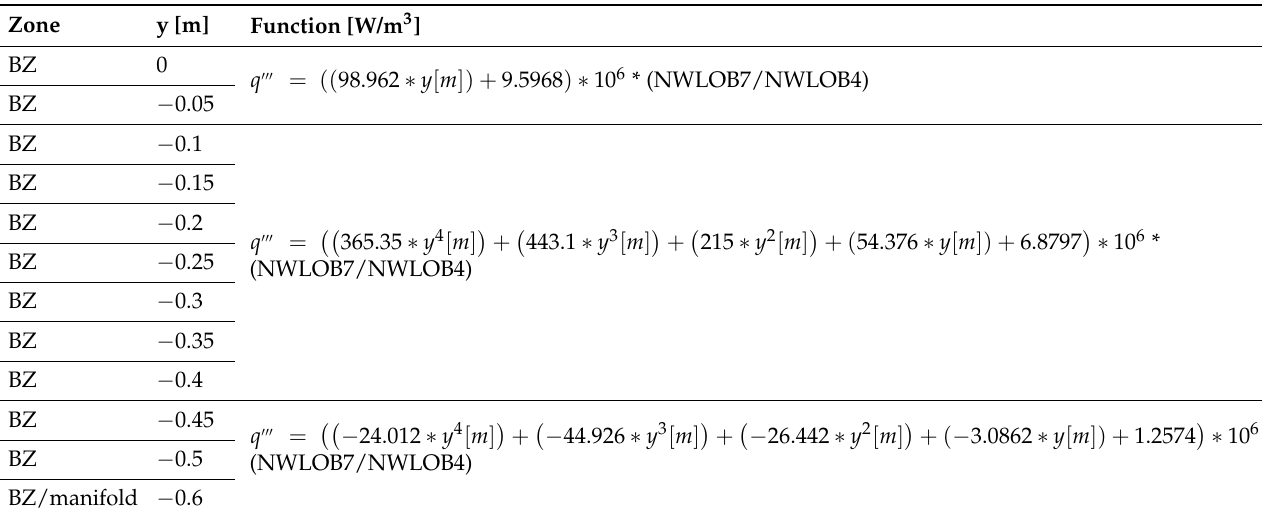
Table A2. Lead–lithium volumetric power deposition curves scaled for the bottom elementary cell